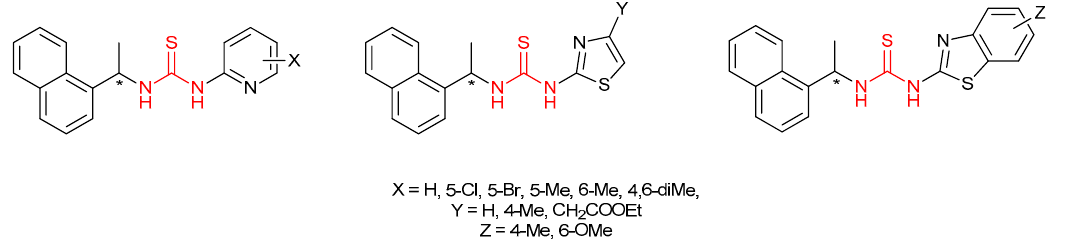
Figure 43 . Chiral naphthyl-substituted thioureas as potential anti-allergic agents [383].